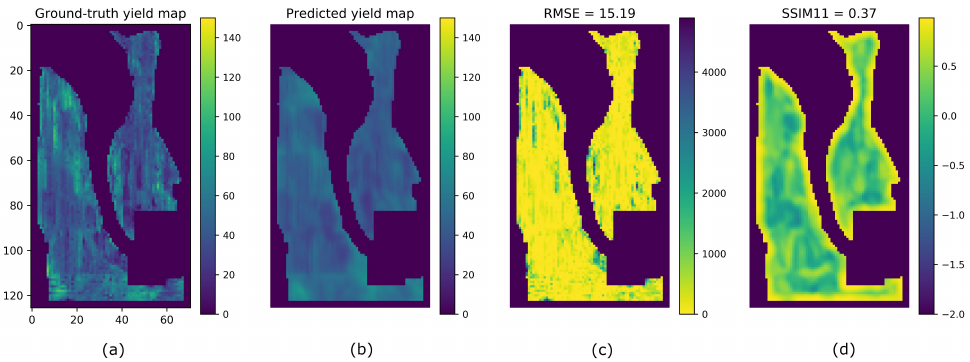
Figure 6. Yield prediction example of the G1 field for the year 2020. ( a ) Ground-truth yield map. ( b ) Predicted yield map using our Hyper3DNetReg with N = 5. ( c ) Square error map. ( d ) SSIMmap _11.